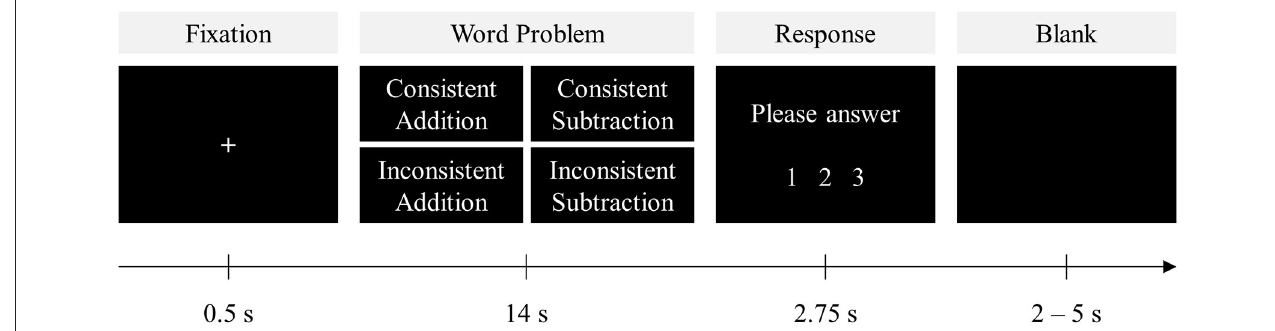
FIGURE 1 | Behavioral paradigm of the present study. Following a fixation sign “ + ” for 500ms, a word problem was presented for 14s. Each problem was orthogonally manipulated and presented in either a consistent or an inconsistent form requiring either addition or subtraction. After the problem presentation, participants were instructed to choose the correct answer from the three provided